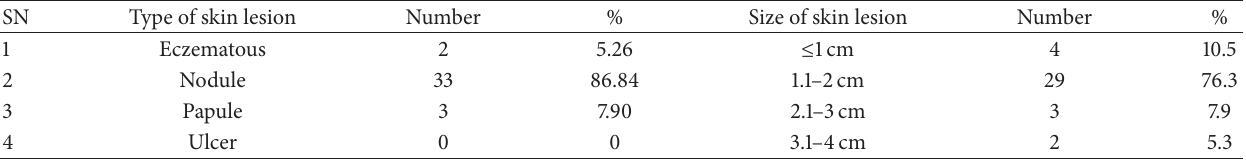
Table 4: Distribution of adnexal tumours according to type and size of skin lesion ( 𝑛 = 38 ).